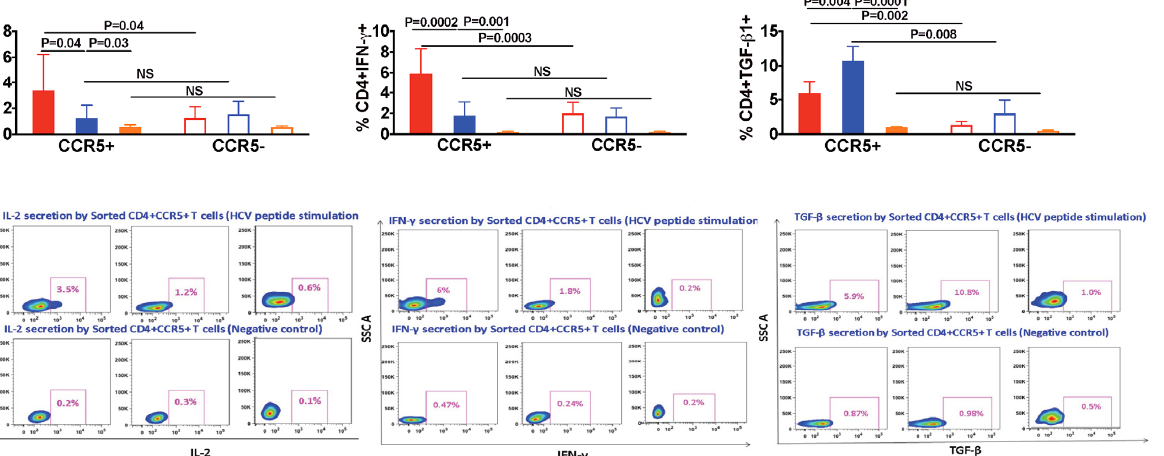
Figure 3. Functional analysis of HCV specific CCR5+ and CCR5 negative CD4+ T cells in HIV/HCV coinfection and HCV monoinfection. ( A ) Flow cytometry figures of a patient and bar graphs with HCV monoinfection, HIV/HCV coinfection and healthy controls demonstrating the differences in the functional response of CD4+CCR5+ after in-vitro stimulation with HCV peptides and media (served as negative control) in terms of IL-2, IFN-gamma and TGF- β production. ( B ) Bar graphs demonstrating the differences in the secretion of pro-Inflammatory (IL-1 β , TNF-A, IL-8) and pro-fibrotic (IL-4 and IL-13) cytokines and Chemokines (RANTES and IP-10) by CCR5+ T cells in HIV/HCV coinfection, HCV monoinfection and healthy controls. Data are expressed as (mean ± SEM) and the Wilcoxon matched-pair signed rank test was used to evaluate the functional differences between CCR5+ and CCR5 negative T cells within the same group and to analyze the differences between the two different groups non-parametric Mann–Whitney test was used. p values less than 0.05 were considered significant. 3.7. Pro-Inflammatory and Pro-Fibrotic Cytokines and Chemokines Are Highly Secreted by CCR5+ T Cells in HIV/HCV Coinfection Following up our previous findings, cellular supernatants were analyzed for various pro-inflammatory and pro-fibrotic cytokines and chemokines in a multiplex assay. In HIV/HCV coinfection, CD4+CCR5+ T cells secreted more pro-inflammatory cytokines IL- 1 β , TNF- α , IL-8 than CCR5 negative cells (IL-1 β : p = 0.02, TNF- α : p = 0.009, IL-8: p = 0.003; Figure 3B) . Similarly, CD4+CCR5+ T cells from coinfected patients secreted more pro- fibrotic cytokines IL-4 and IL-13 [26] than CCR5 negative cells (IL-4: p = 0.007, IL-13: p = 0.009; Figure 3B). Increased IL-4 and IL-13 secretion from CD4+CCR5+ T cells was also seen in coinfection as compared with monoinfection ( p = 0.04 for both) and healthy controls (See Figure 3B). We also evaluated IP-10/CXCL10 and RANTES/CCL5 (pro- fibrotic chemokines) secretion. In HIV/HCV coinfection, both were increased from CD4+CCR5+ T cells, compared with CCR5 negative cells ( p = 0.03 for both IP-10(CXCL10)